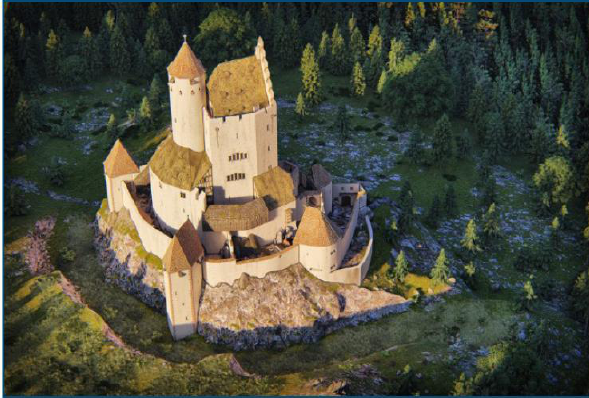
Figure 5: photo-realistic rendering of the Kagenfels’ 3D model (Benazzi, 2017) The way the levels of uncertainty have been integrated to the process of restitution is explained in section 4.